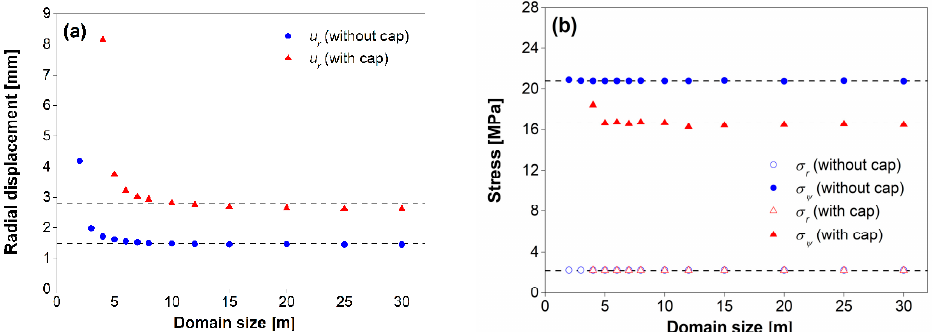
Figure 5. Variation of the ( a ) radial displacements and ( b ) stresses at point M (see Figure 3b) as a function of domain size (with m = 0.02 m) obtained from the MSDP u ‐ EPP model with and without function of domain size (with m = 0.02 m) obtained from the MSDP u -EPP model with and the cap.